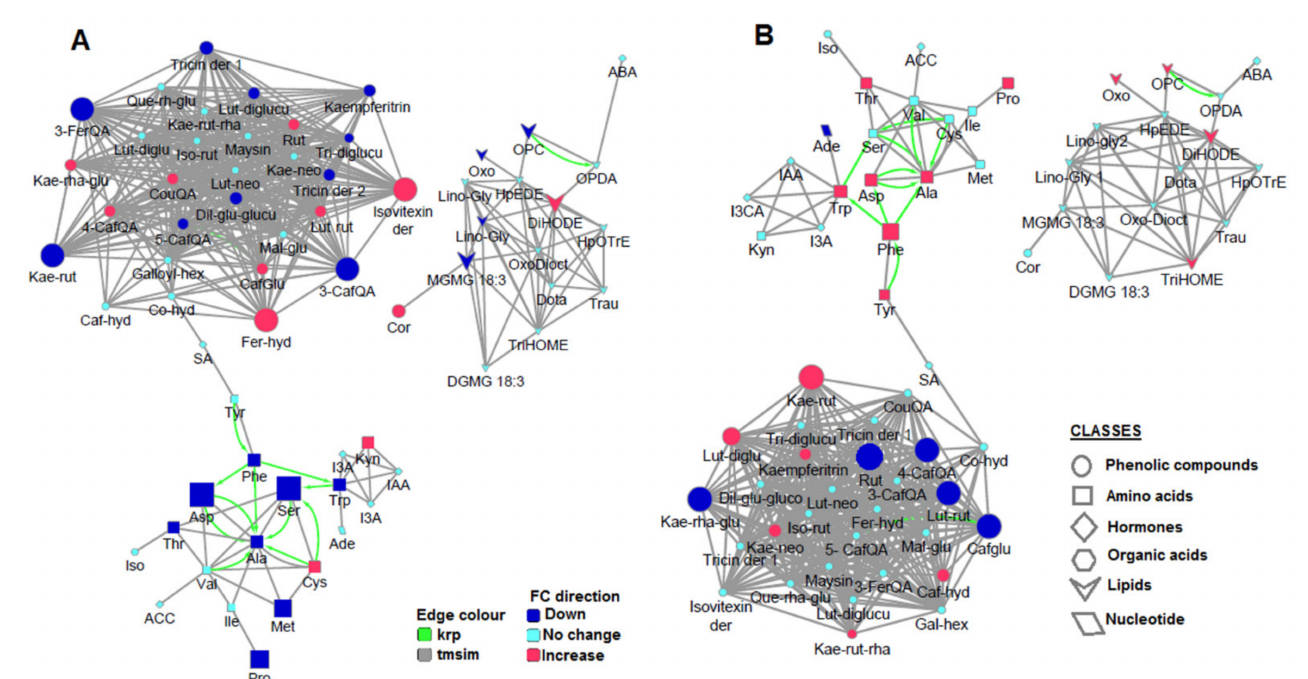
Figure 4. MetaMapp metabolite network visualization depicting the effects of nutrient starvation on ( A ) non-treated plants and ( B ) HS-treated plants. Red nodes indicate increased metabolites, whereas the blue indicates a decrease. Node size indicates the magnitude of fold-change. Compounds are connected by KEGG reaction pair (krp, green line), and chemical similarity (grey